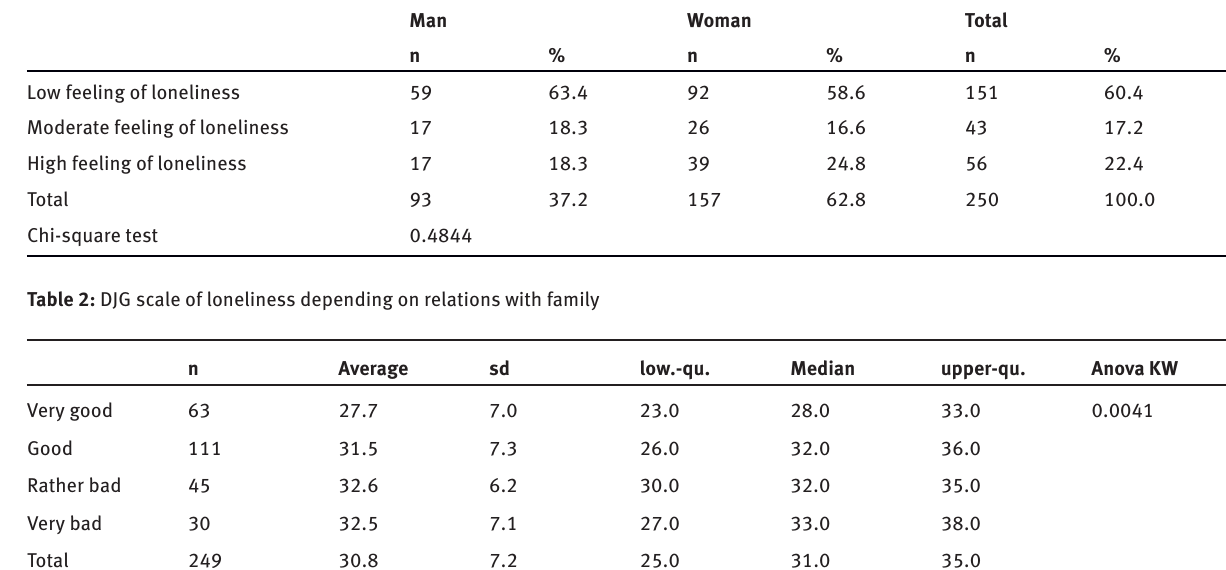
Table 1: Feeling of loneliness among those surveyed on the DJG scale depending on sex Man